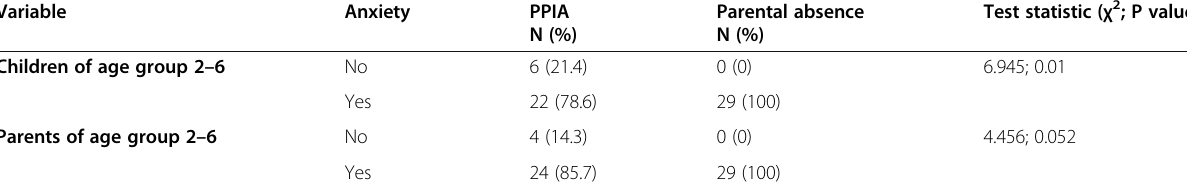
Table 5 Comparison of preschool age group (2 – 6 years), and their parent ’ s anxiety at induction of anaesthesia Variable